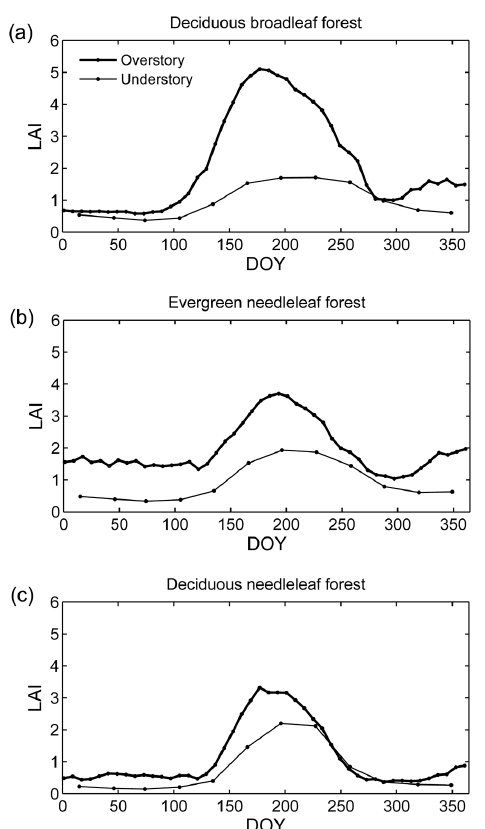
Figure 7. Time series of the GLOBMAP overstory (thick lines) and understory (thin lines) LAI for (a) DBFs, (b) ENFs and (c) DNFs in the Northern